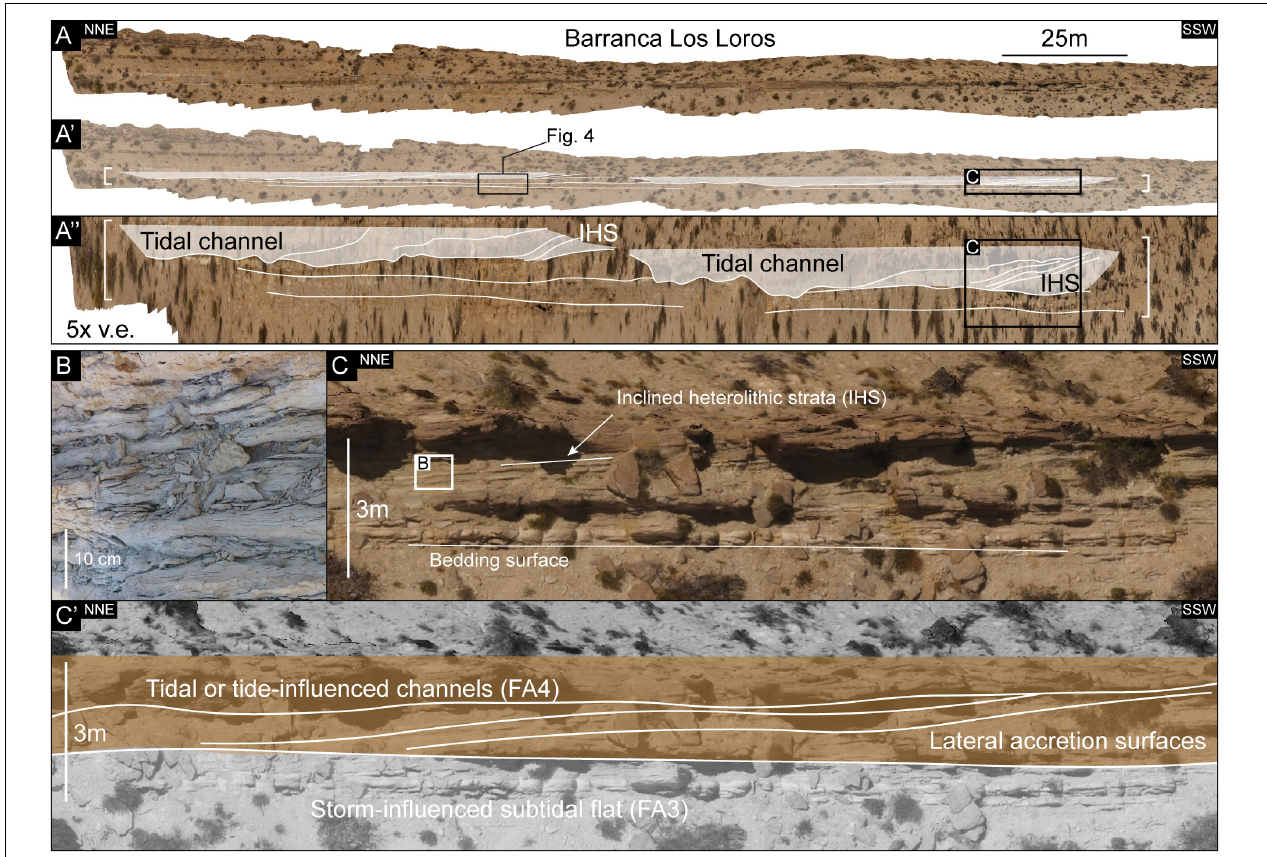
FIGURE 6 | Overview of FA4 deposits at Barranca Los Loros ( Figure 1D ). Figure location is indicated in Figure 9 . (A) Orthorectified overview photograph of FA3–FA4 interval. (A’) Overlay interpretation with FA4 tidal channels. (A”) Same as A’ , five times vertical exaggeration. (B) Close-up picture of inclined heterolithic strata (IHS). (C) Close-up orthorectified photograph with (C’) overlay interpretation of FA4 tidal channel and adjacent lateral accretion surfaces (IHS), overlying storm-influenced subtidal flat deposits (FA3).